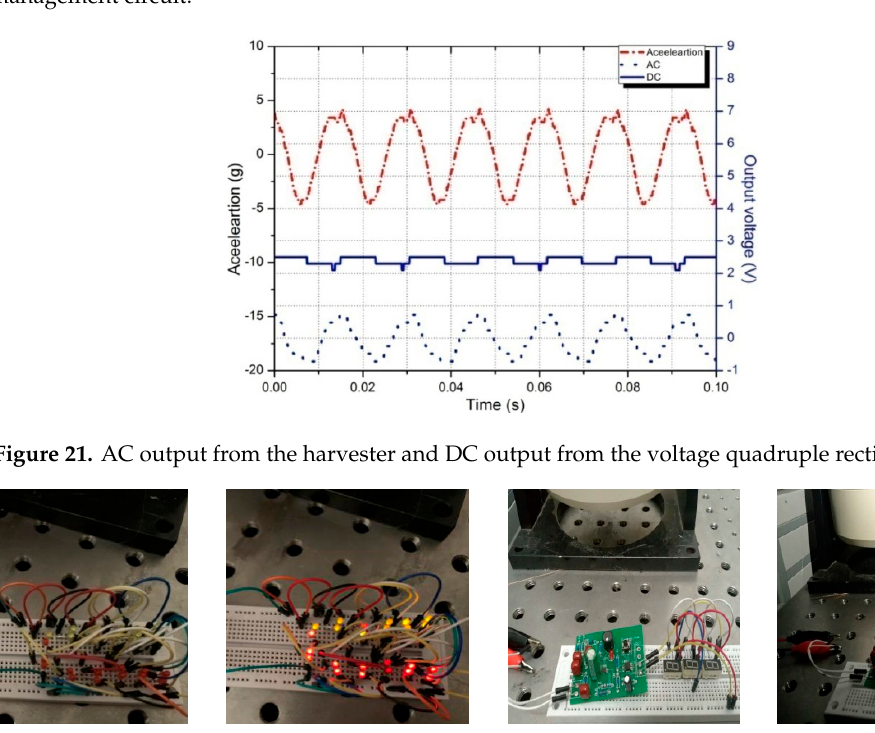
Figure 20. Schematic diagram ( a ) and actual printed circuit board ( b ) of energy harvesting and management circuit.